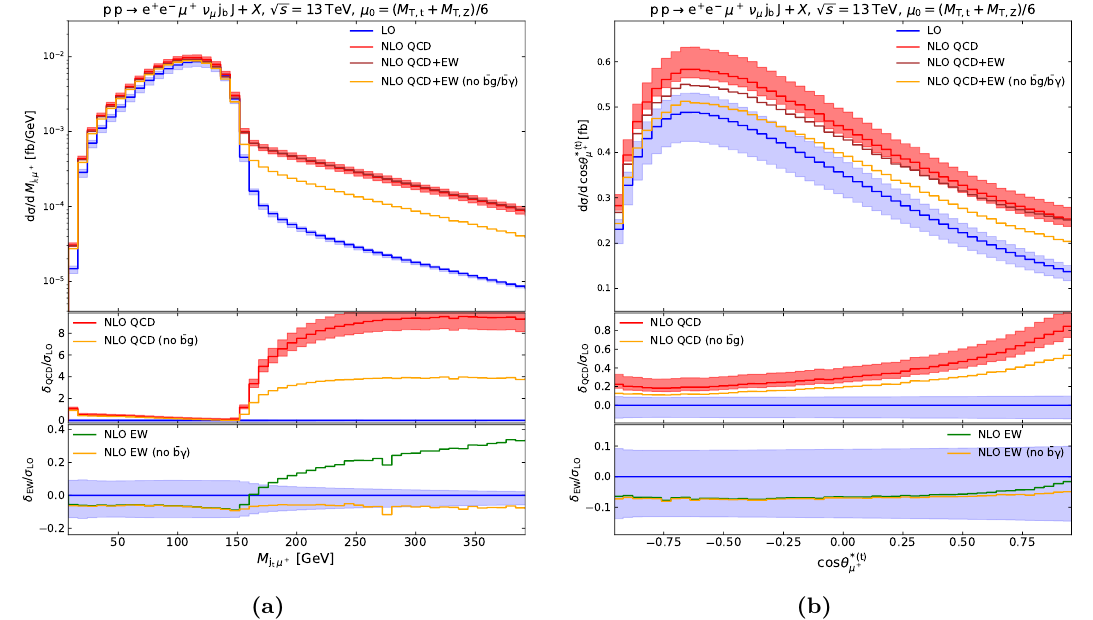
Figure 10. Invariant-mass distribution of the top-decay jet and the anti-muon, and distribution of the cosine of the angle of the anti-muon with respect to the direction of the boost from the laboratory frame to the top-quark rest frame in the latter frame. The definition of the angle, given in eq. (3.8), makes uses of the kinematic reconstruction routine given in section 2.4.